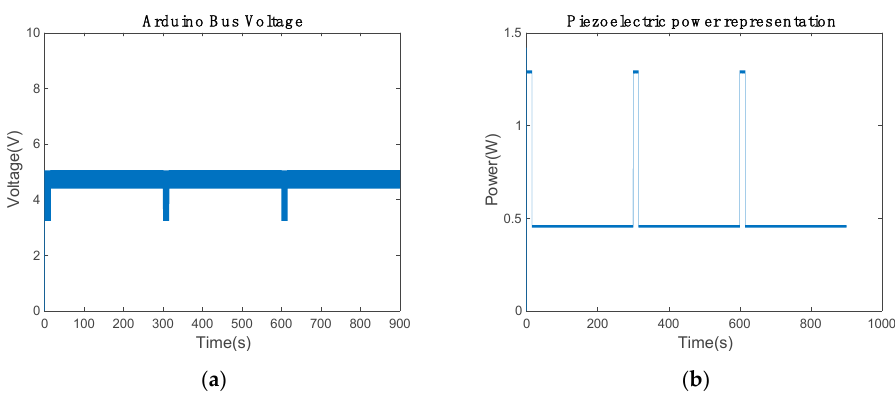
Figure 15. Maximum power of the energy harvester: ( a ) low-cost 4G shield bus voltage and ( b )